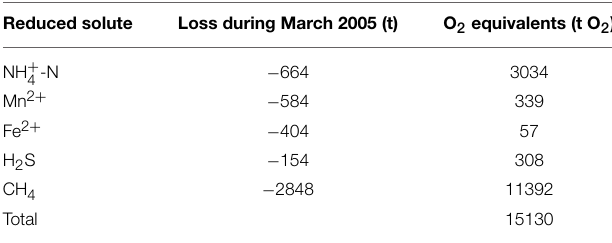
TABLE 2 | Quantities of reduced substances that disappeared from the monimolimnion during lake overturn between 1 and 30 March. Reduced